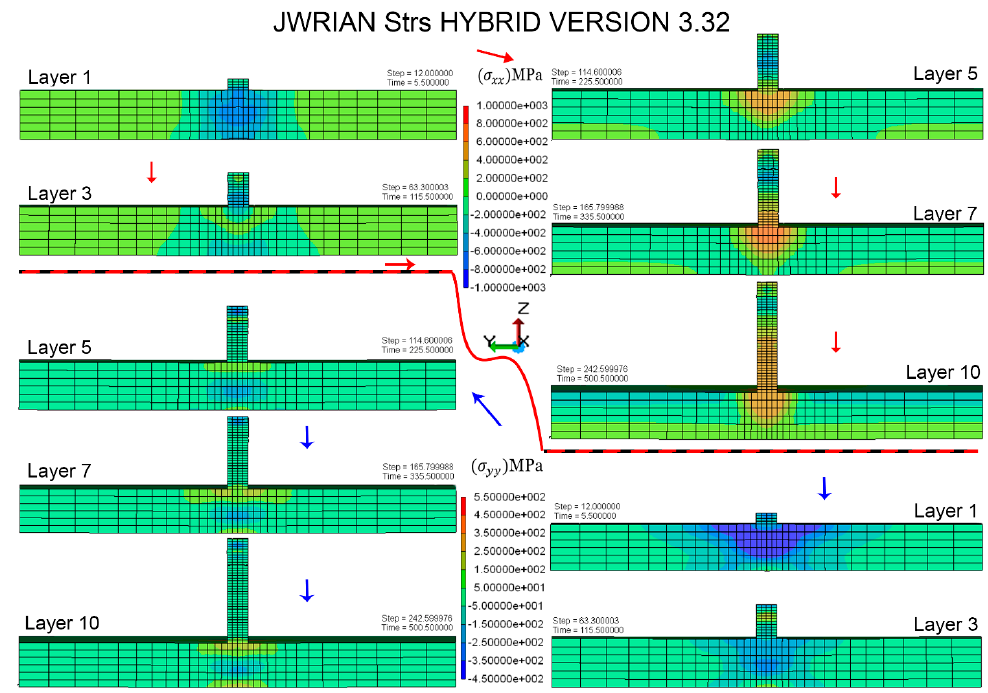
Figure 8. Longitudinal and transverse thermal stress distribution for subsequent layering in laser cladding simulation.